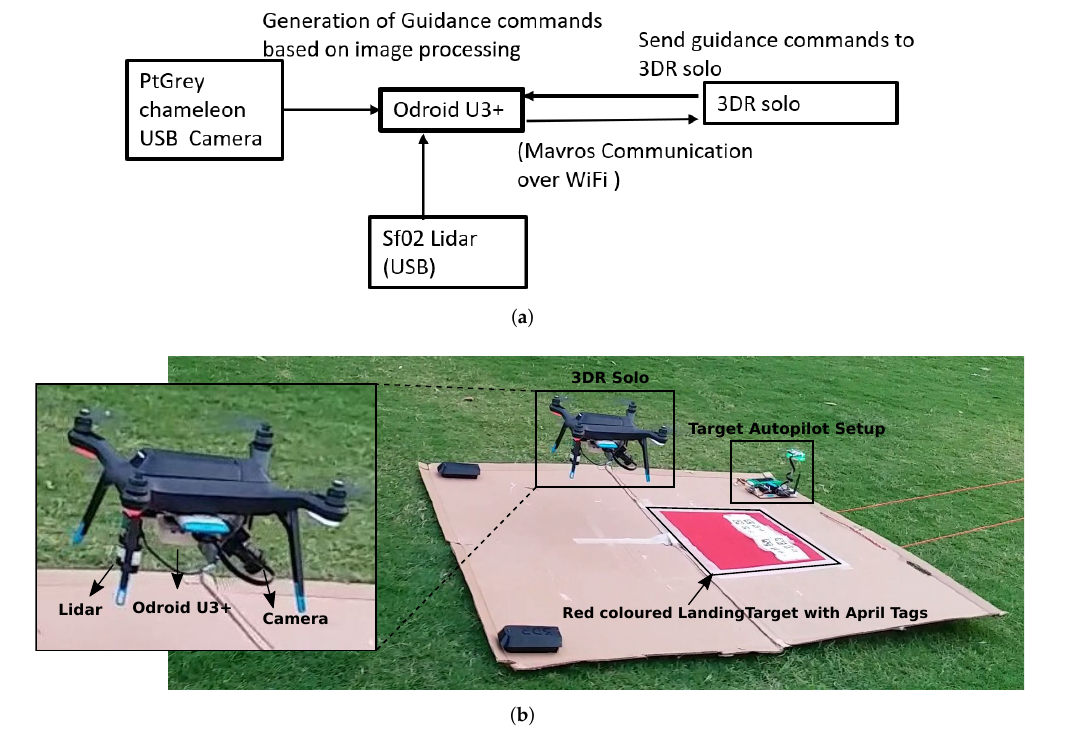
Figure 10. ( a ) Hardware setup and information flow diagram consisting of 3DR Solo (quadrotor), Odroid U3+, and PtGrey USB camera; ( b ) quadcopter with whole hardware interface about to land on target. Inset Figures show 3DR solo setup and detected target from onboard